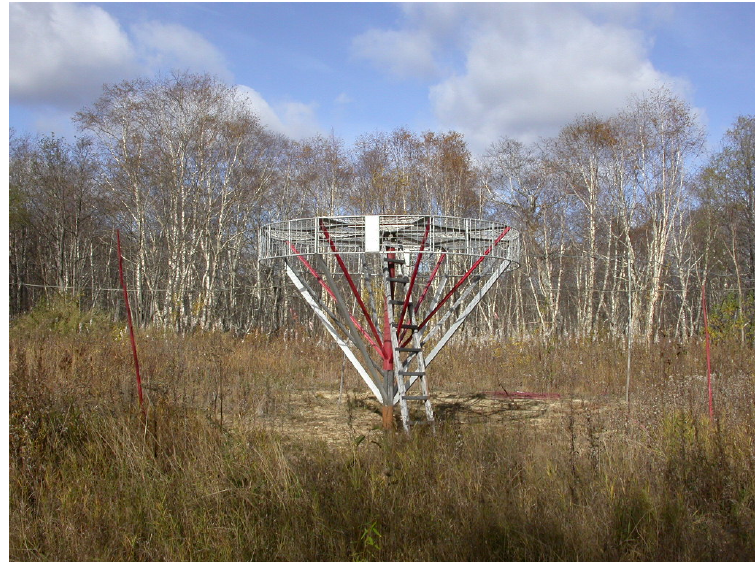
Figure 3. Installation of the Pole-2 instrument at the observatory. The height of the sensor installation was determined by the maximum snow level in winter. The snow level in winter in the area of electric field measurements reaches 2.7 m (Figure